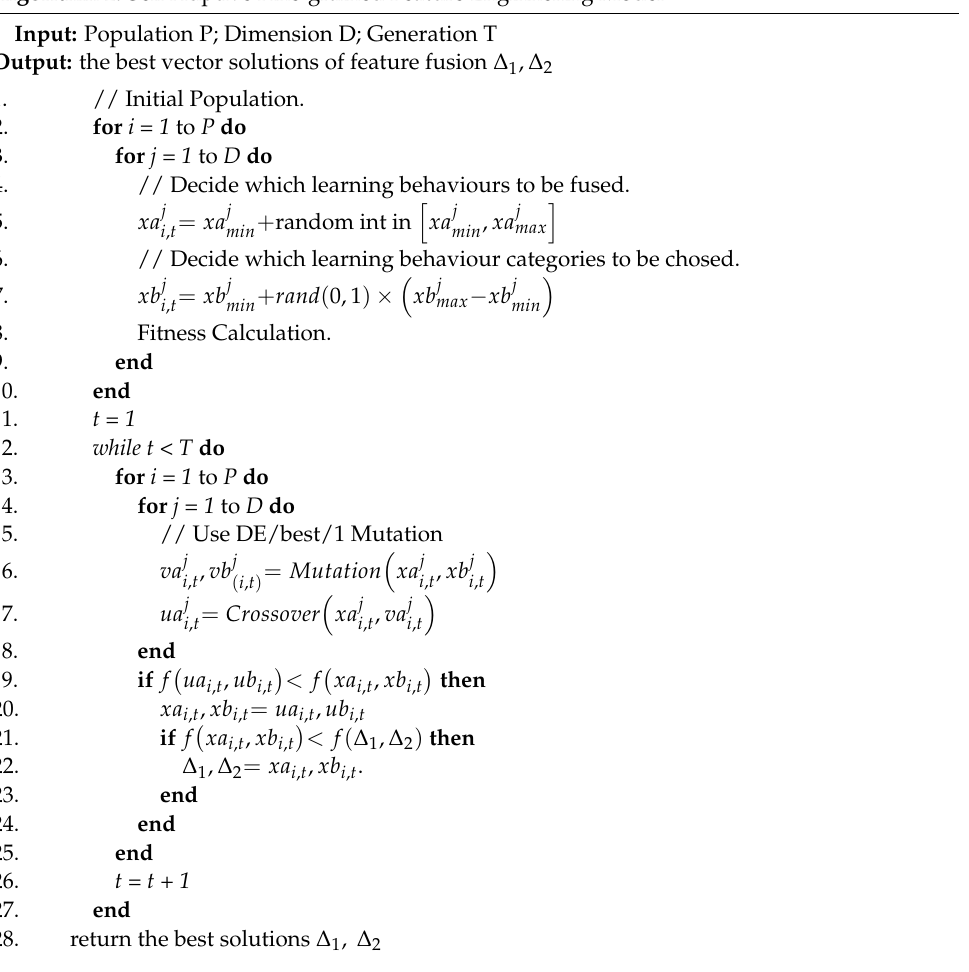
Algorithm 2: Self Adptive Fine-grained Feature Enginnering